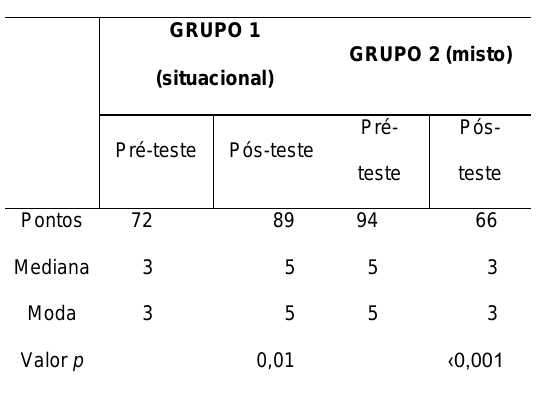
Tabela 4. Resultado do pré-teste e do pós-teste para conhecimento tático processual KORA: RE convergente (inteligência).